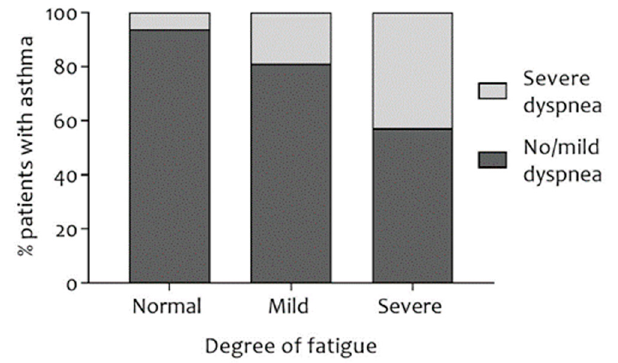
Figure 2. Proportion of asthmatic patients with normal/mild dyspnea (MRC < 3) or severe dyspnea (MRC ≥ 3) after stratification for the degree of fatigue. A statistically significant association